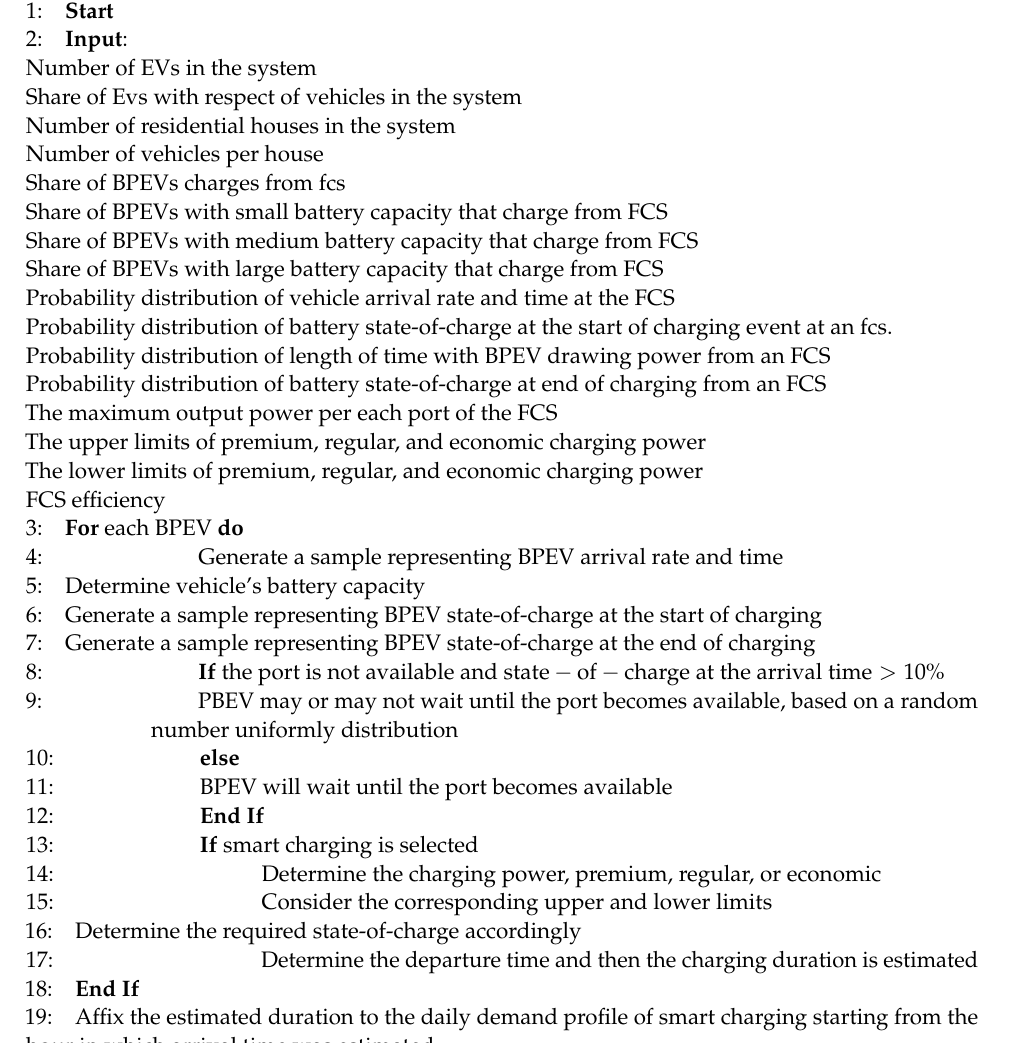
Algorithm 1. Estimation and Assessment of Smart and Uncontrolled Charging